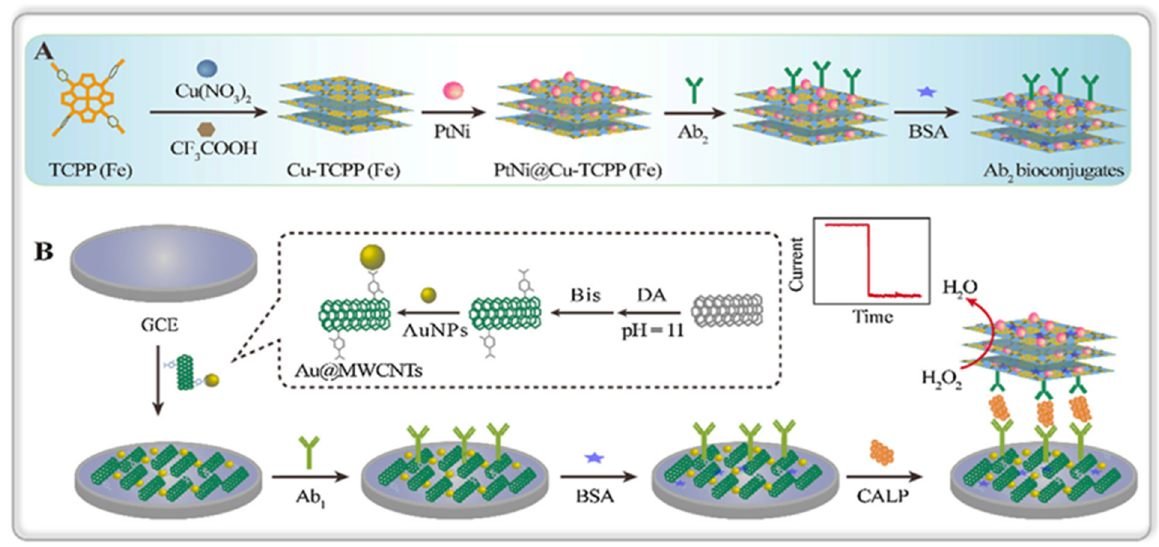
Figure 6. Illustrative schemes of: ( A ) the preparation procedure of PtNi@Cu-TCPP(Fe)-Ab 2 bioconjugate, and ( B ) the construction of the sandwich immunosensor. Reprinted from [74] with permission.